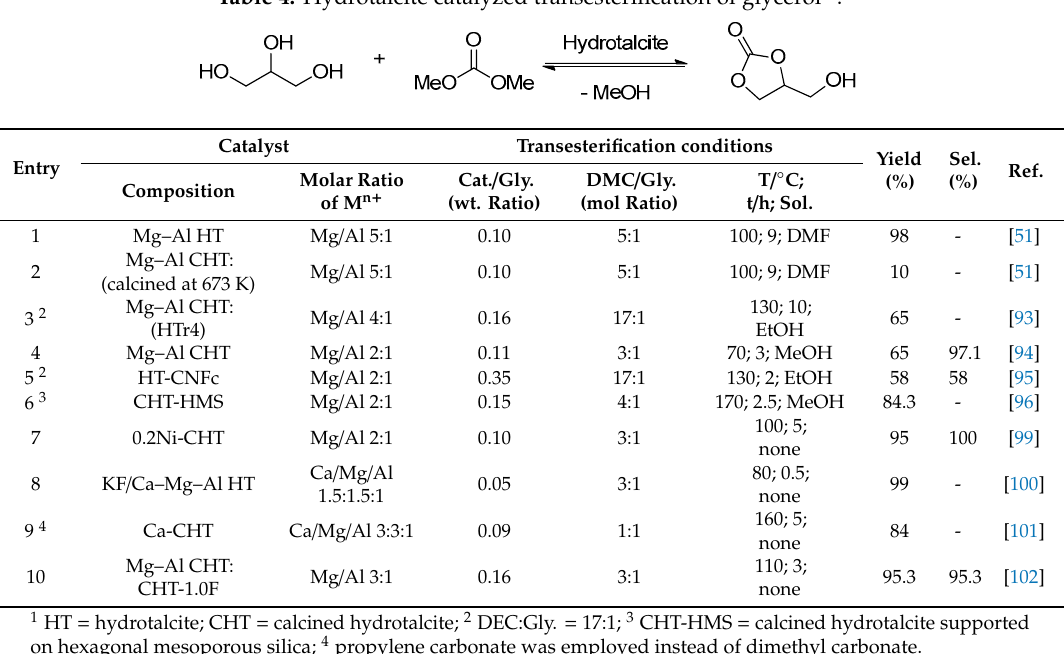
Table 4. Hydrotalcite catalyzed transesterification of glycerol 1 .